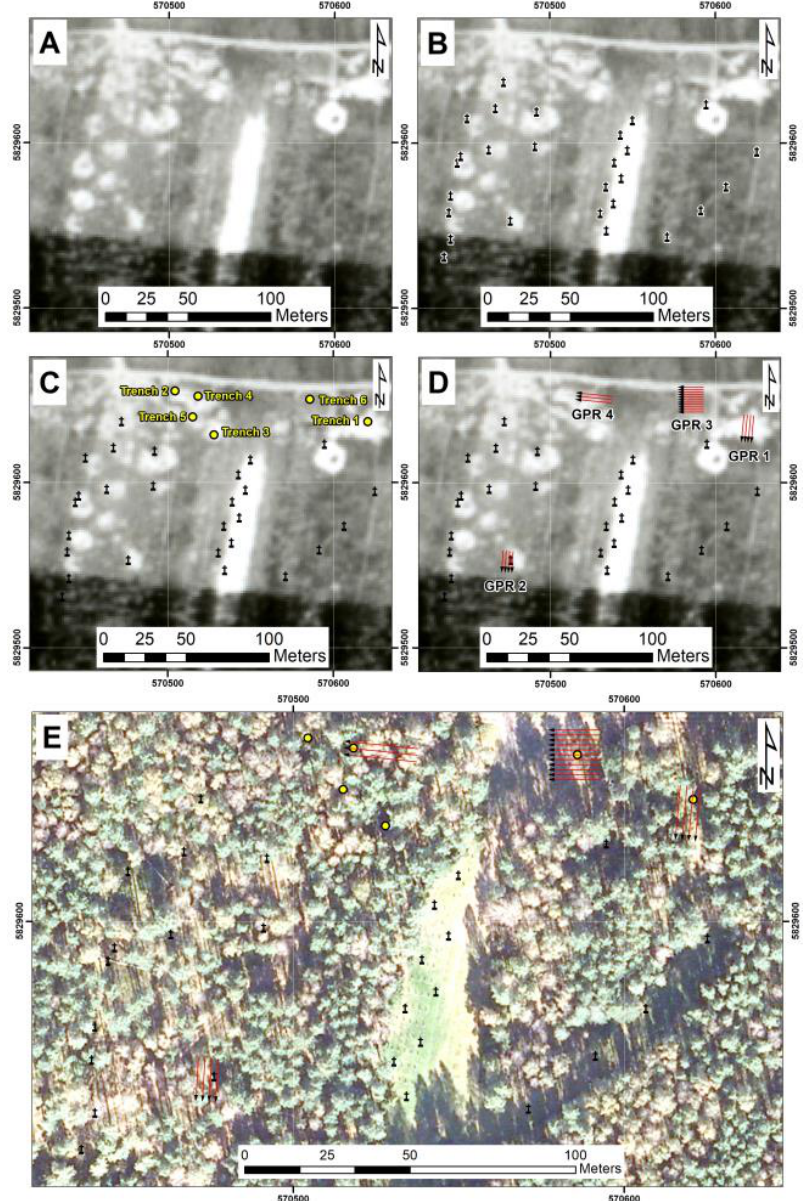
Figure 7. ( A ) Digital orthophotomap from an aerial photo from 1944 (© NARA); ( B ) orthophotomap from 1944 with superimposed grave pits commemorated by crosses on the site (© NARA); ( C ) orthophotomap from 1944 with superimposed grave pits commemorated by crosses on the site and test digs (© NARA); ( D ) orthophotomap from 1944 with grave pits commemorated by crosses on the site and GPR measurement profiles (© NARA); ( E ) compilation of vector features presented on drawings 7B–7D on the base of the orthophotomap from 2017 (© Head Office of Geodesy and Cartography in Poland). The location of ground-penetrating radar survey profiles (GPR). Coordinate grid: Polish Coordinate System 1992 (EPSG: 2180).